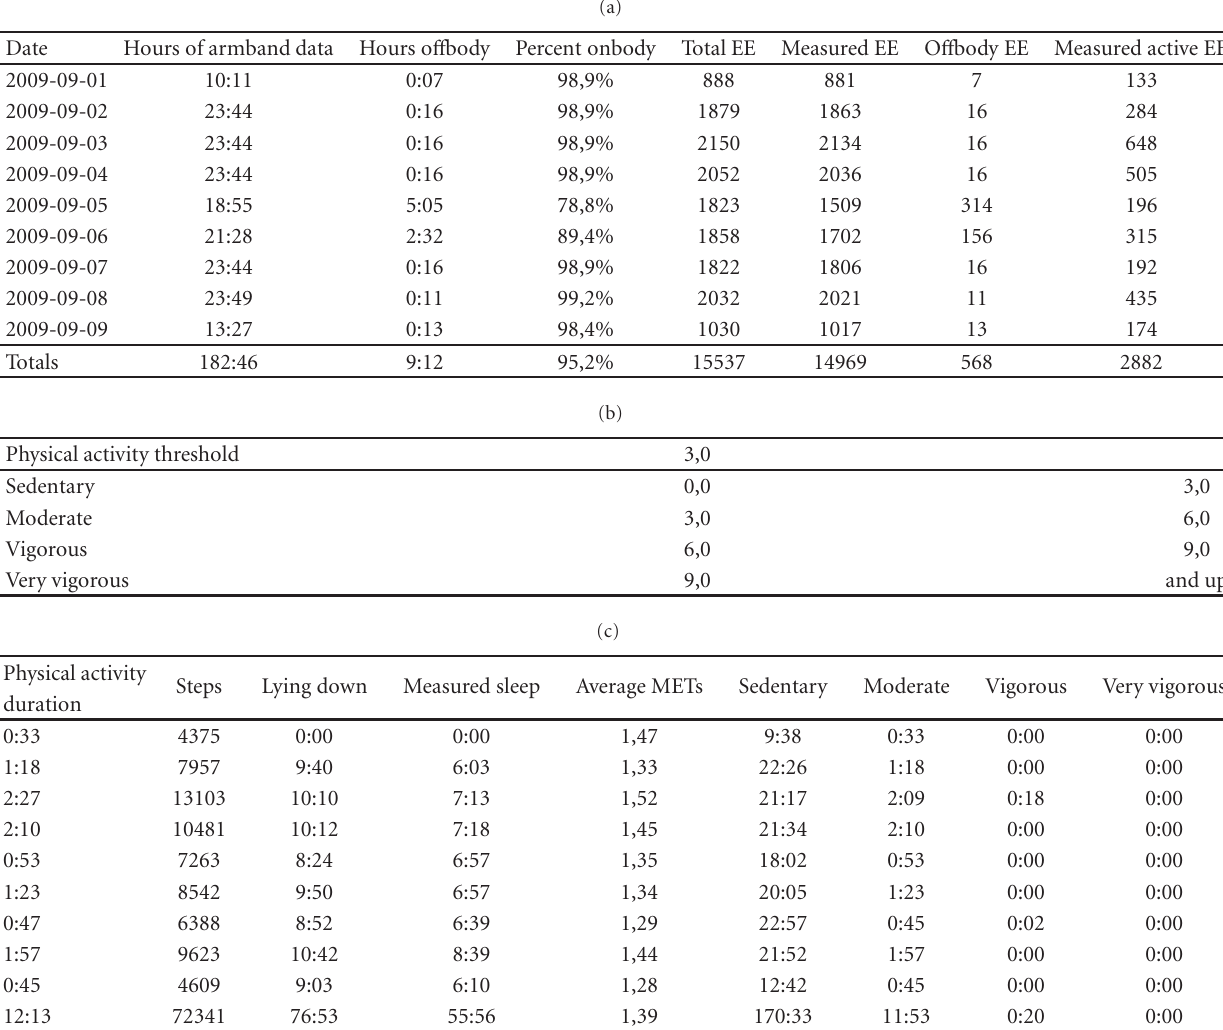
Table 2: (a) and (b) Summary sheet for all data for subject 3 (8 days), columns 1–8. (c) Summary sheet for all data for subject 3 (8 days), columns